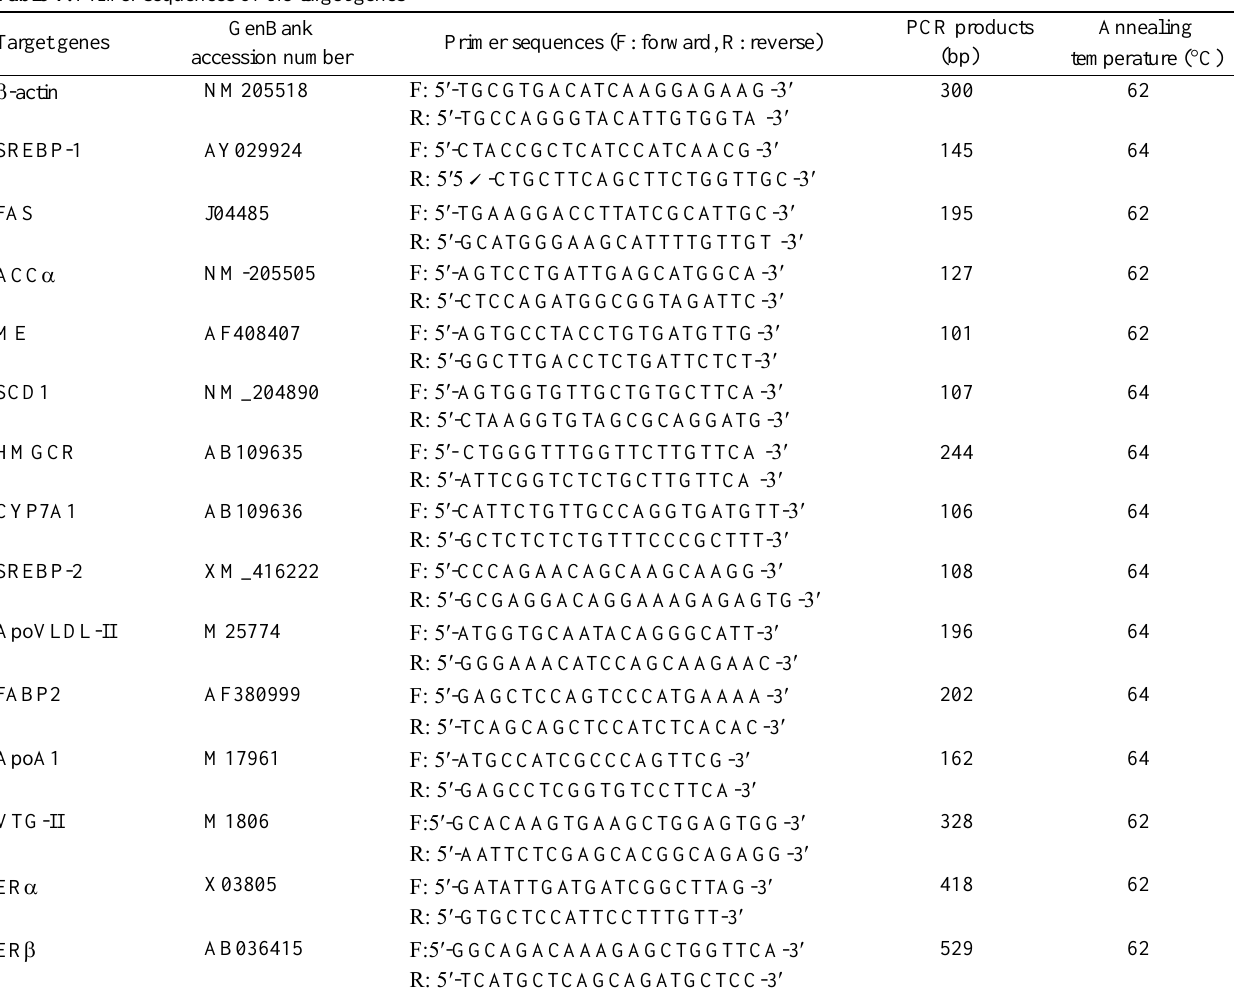
Table 1. Primer sequences of the target